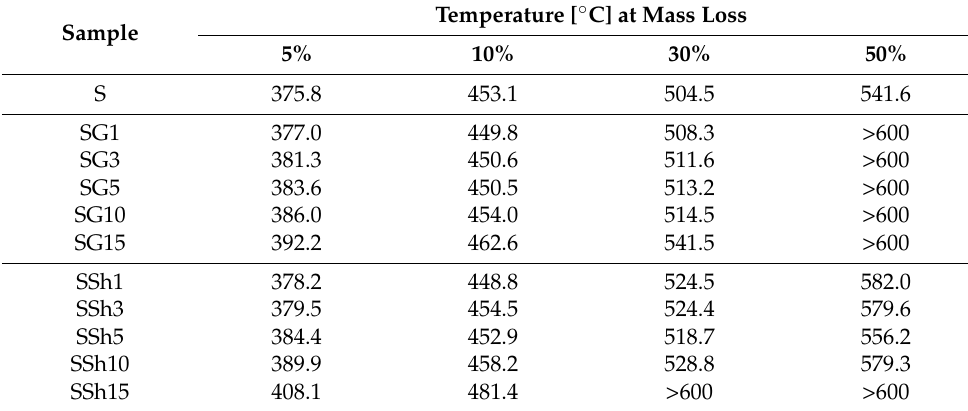
Table 4. TG data for pure Sylgard and its composites.